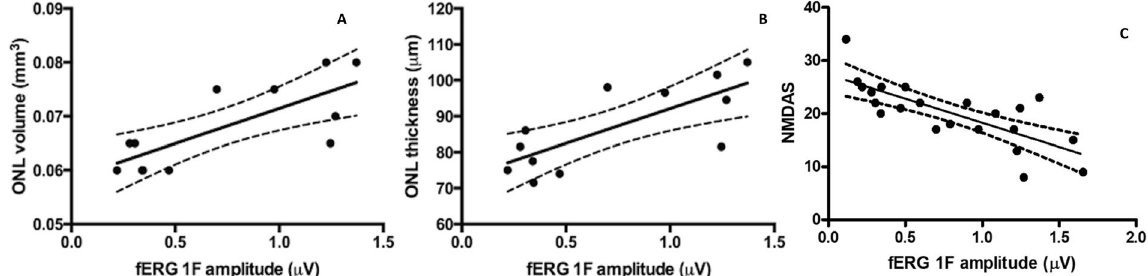
Figure 2. Scatterplot showing the positive correlation between fERG 1F amplitude and ONL volume ( A ) and thickness ( B ); scatterplot showing the inverse correlation between fERG 1F amplitude and Newcastle scale score in patients with mitochondrial disease (mt disease) ( C ).